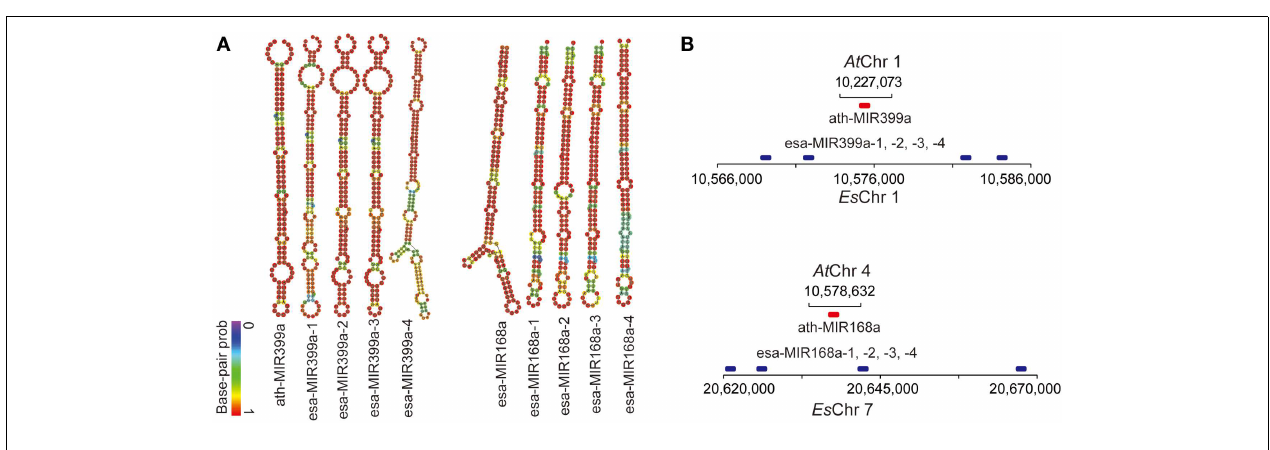
precursors in E. salsugineum . (B) Copy number variation of stress-related microRNA genes MIR399a and MIR168a between A. thaliana and E. salsugineum